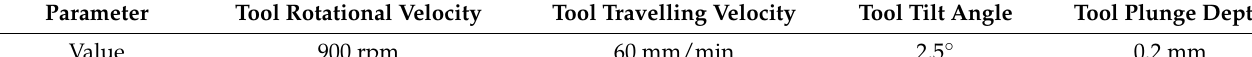
Table 3. Welding process parameter.